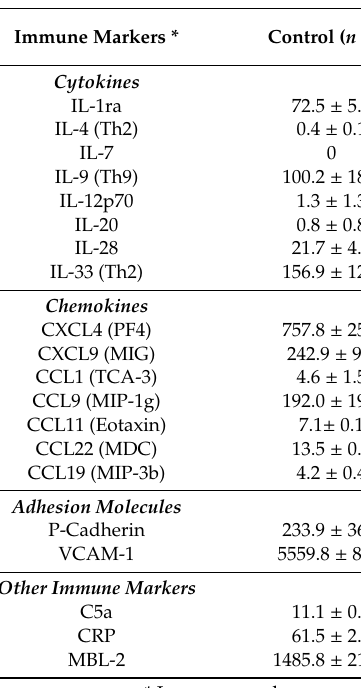
Table 2. Alum alone significantly increases the in vivo levels of multiple immune